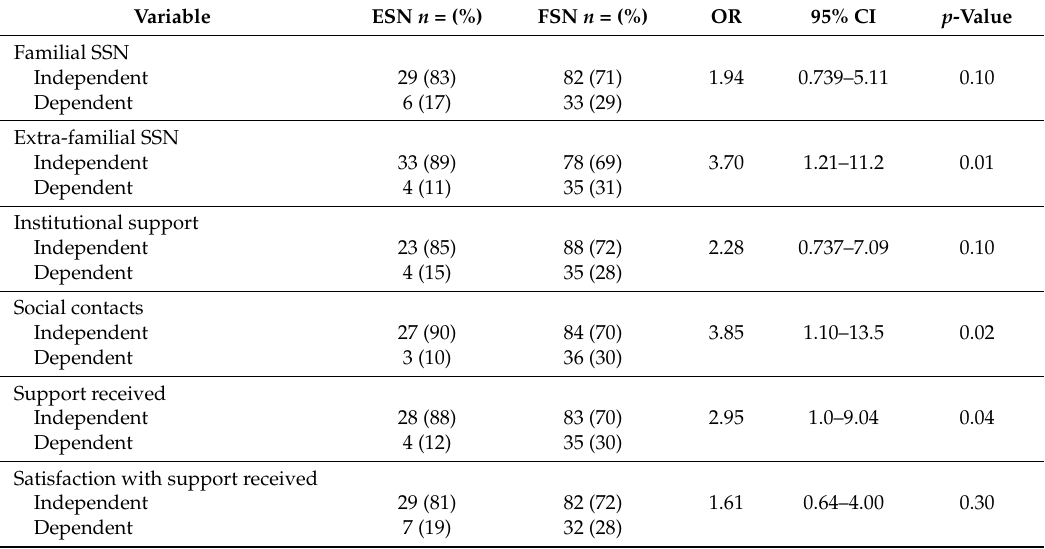
Table 4. Social support networks as a risk factor for physical functioning tasks (PFT) dependence.